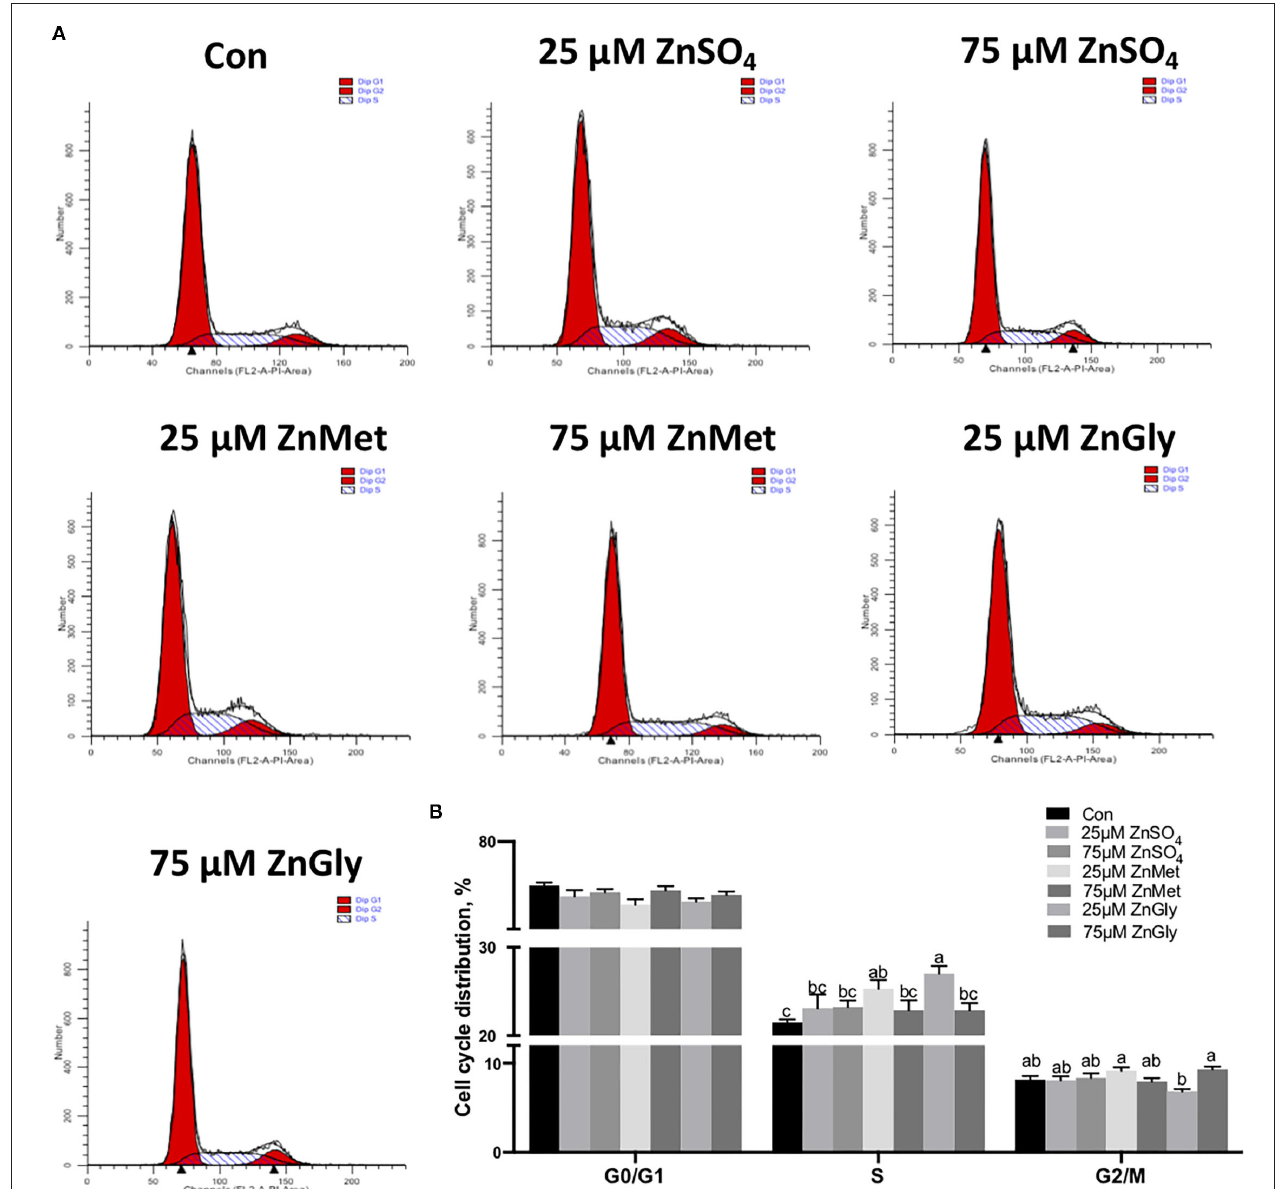
FIGURE 4 | Cell cycle distribution (A) and its analyzation (B) of C2C12 cells by adding different zinc